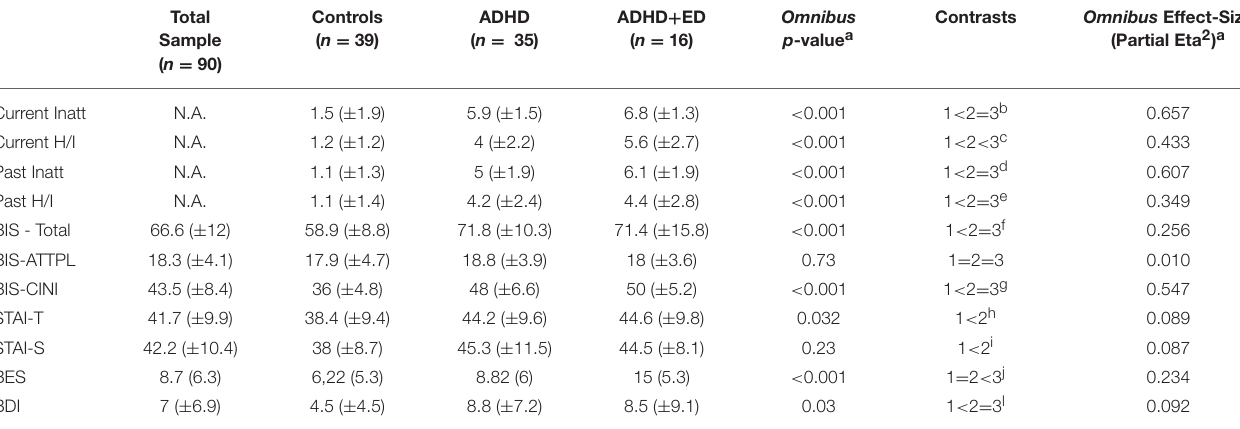
TABLE 2 | ADHD symptoms and self-report psychopathological measures.